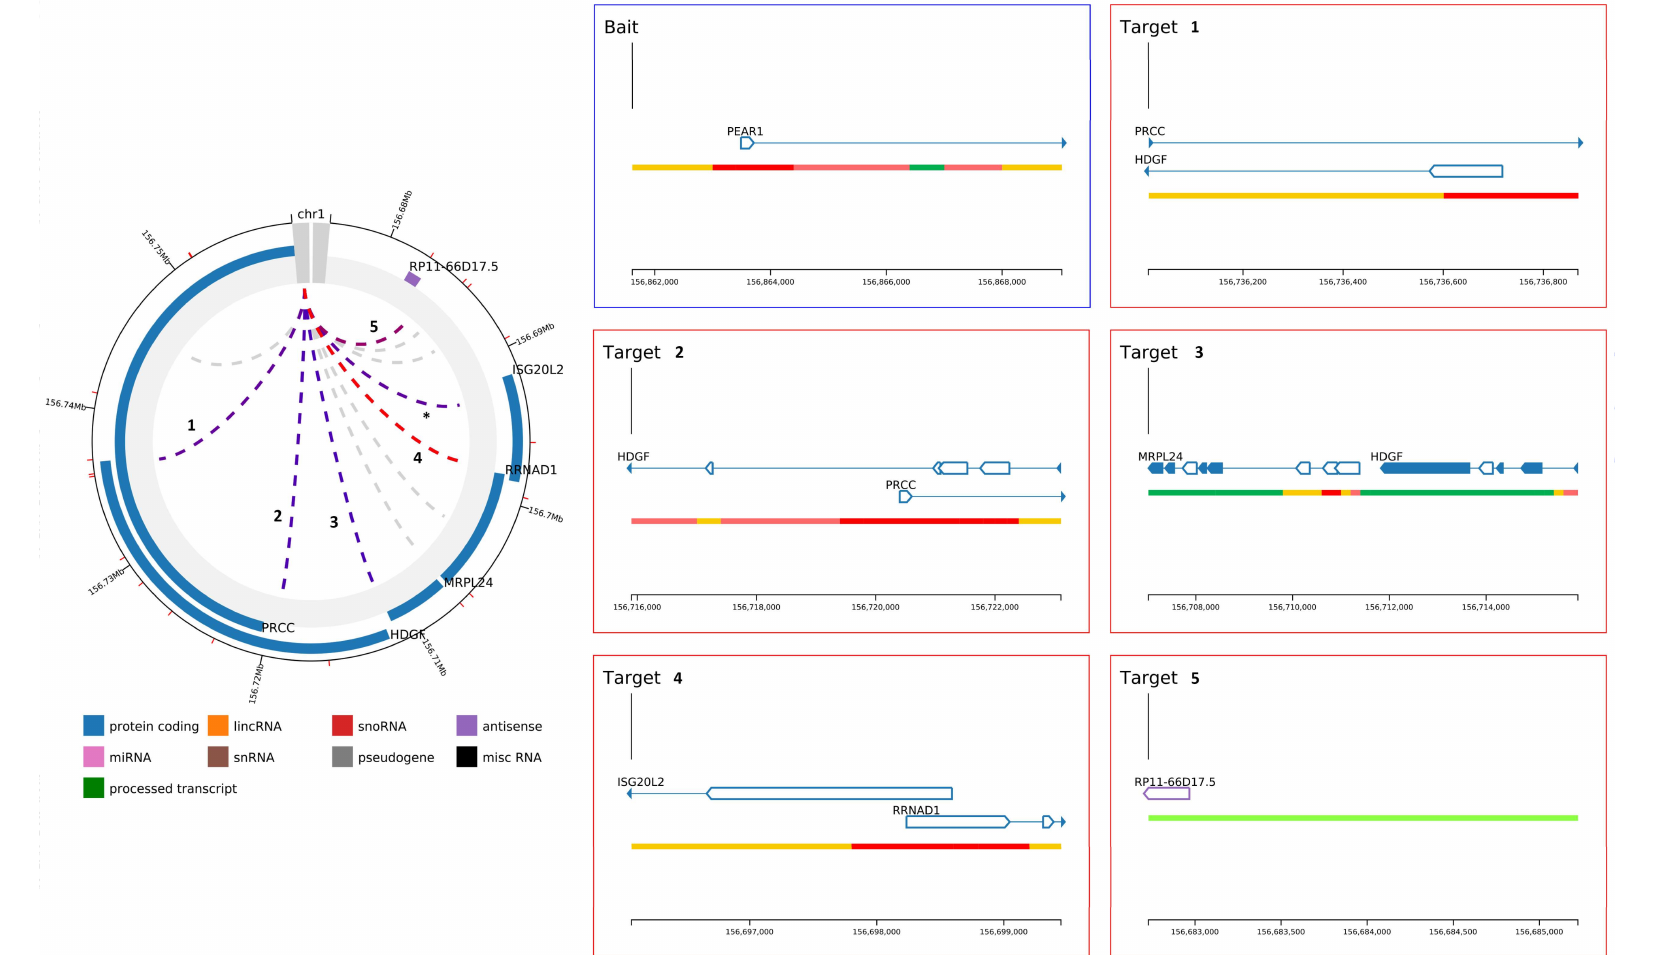
Figure 4. Magnification of PEAR1 chromosome interactions in endothelial precursors and MKs. Magnification of shared PEAR1 chromosome interactions among endothelial precursors and MKs in the top left panel. Each interaction is indicated with a number and the correspondent magnification displayed in the right panel reporting gene names, regions of interactions and direction of transcription. *: PEAR1 interaction that involved a second region of the gene corresponding to location chr1:156,881,919–156,903,177 and not covering PEAR1 enhancer region analysed in this